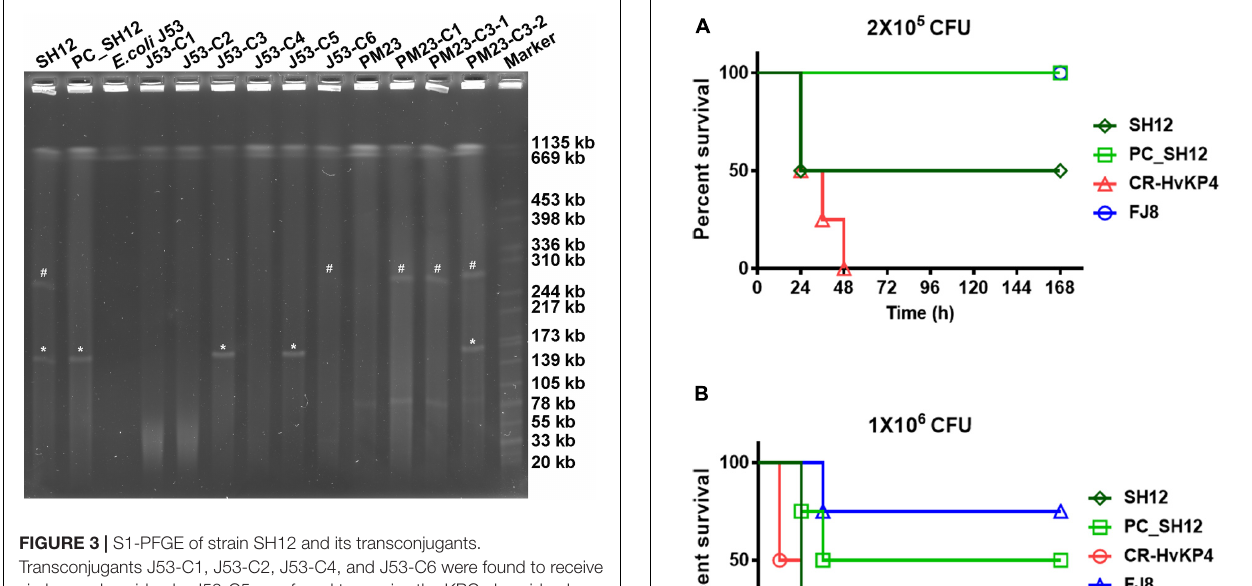
marker gene of virulence plasmid pSH12_Vir by PCR, indicating